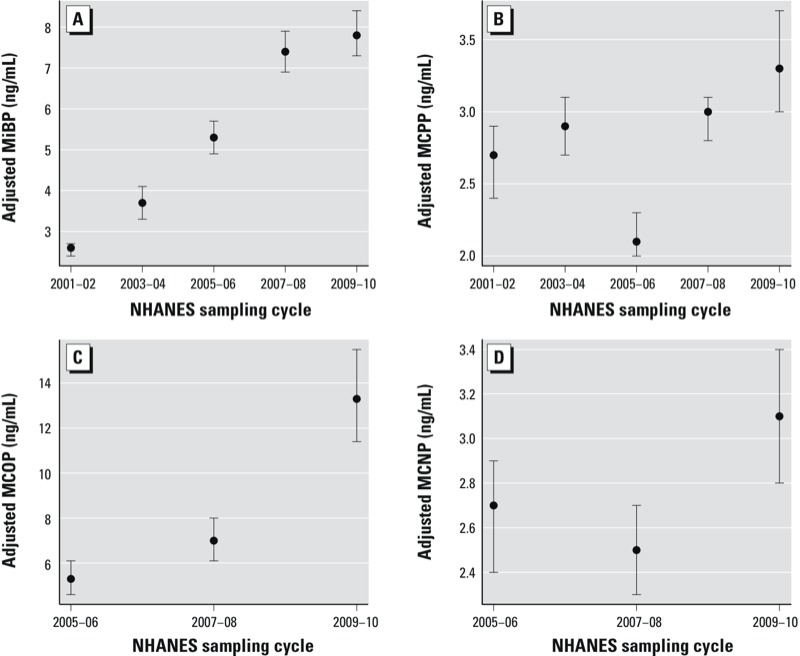
Association between phthalate metabolites and NHANES sampling cycle in the general U.S. population for (A) MiBP (n = 11,071; parent phthalate, DiBP; p < 0.0001); (B) MCPP (n = 11,071; parent phthalates, DnOP and a nonspecific metabolite of high-molecular-weight phthalates; p < 0.0001); (C) MCOP (n = 6,375; parent phthalate, DiNP; p < 0.0001); and (D) MCNP (n = 6,375; parent phthalate, DiDP; p = 0.004). Models are adjusted for urinary creatinine. Data points represent LSGM and error bars represent 95% CIs. Corresponding numeric data are provided in Supplemental Material, Table S3. p-Value for the overall comparison between groups assessed by the Wald Test.